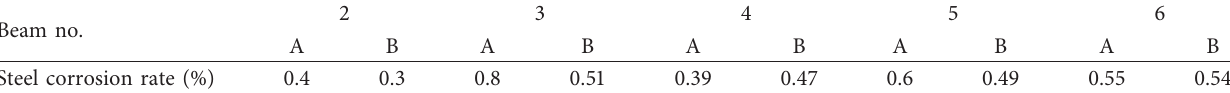
Table 3: Steel corrosion